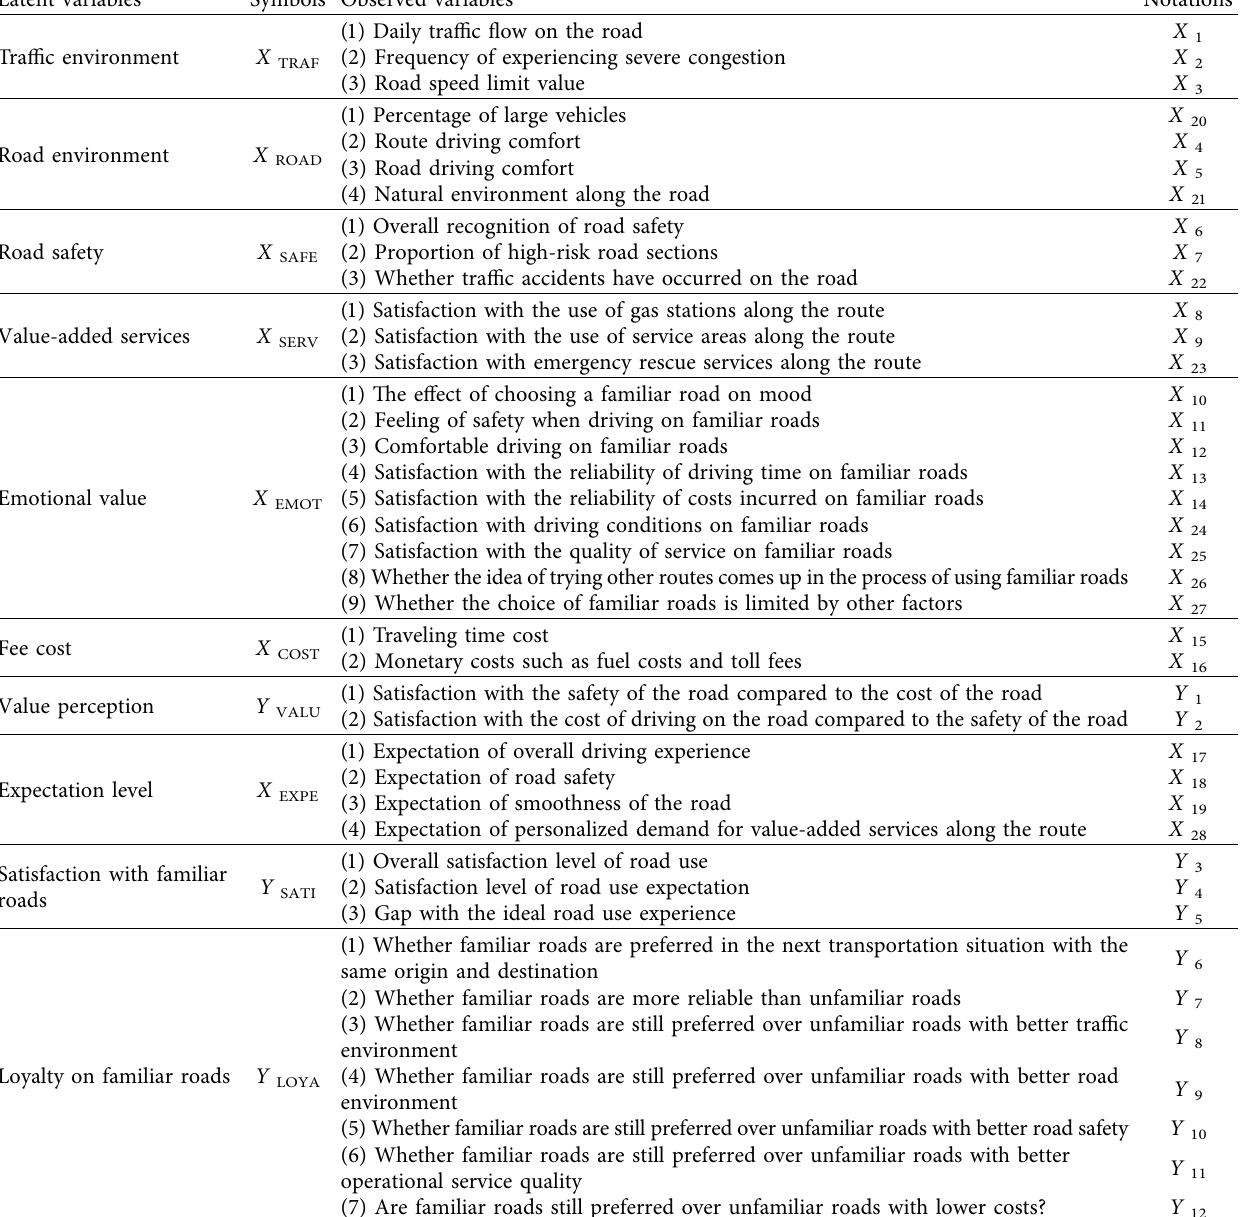
Table 1: Te designed content of questionnaires in the